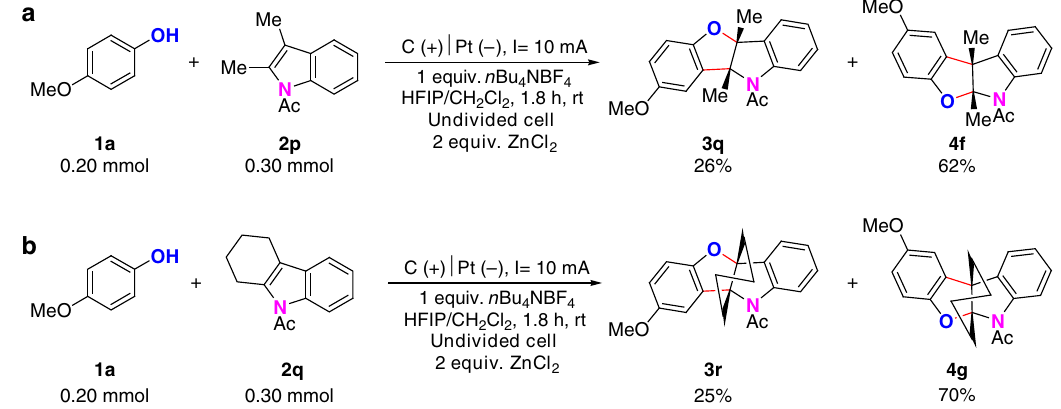
Fig. 4 Synthesis of benzofuro[3,2-b]indolines from 2,3-disubstituted N -acetylindoles. a Reaction with 2,3-dimethyl- N- acetylindole by adding ZnCl 2 . b Reaction with N -acetyl tetrahydrocarbazole by adding ZnCl